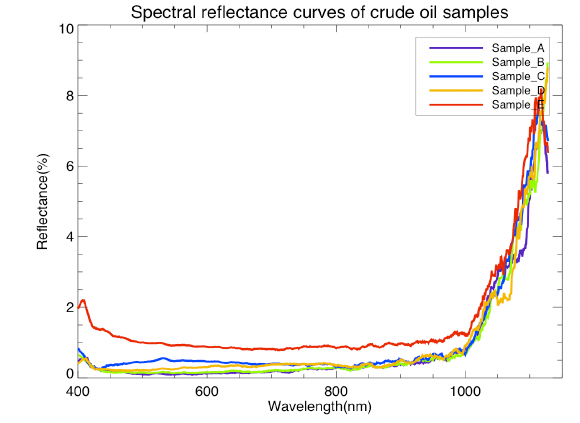
Figure 5. Spectral reflectance plot of five different crude oil